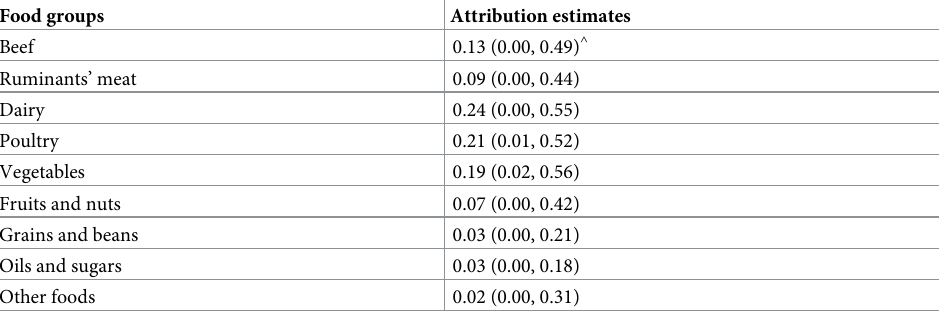
Table 4. Attribution of foodborne disease due to enterotoxigenic Escherichia coli in Ethiopia to food groups. Food